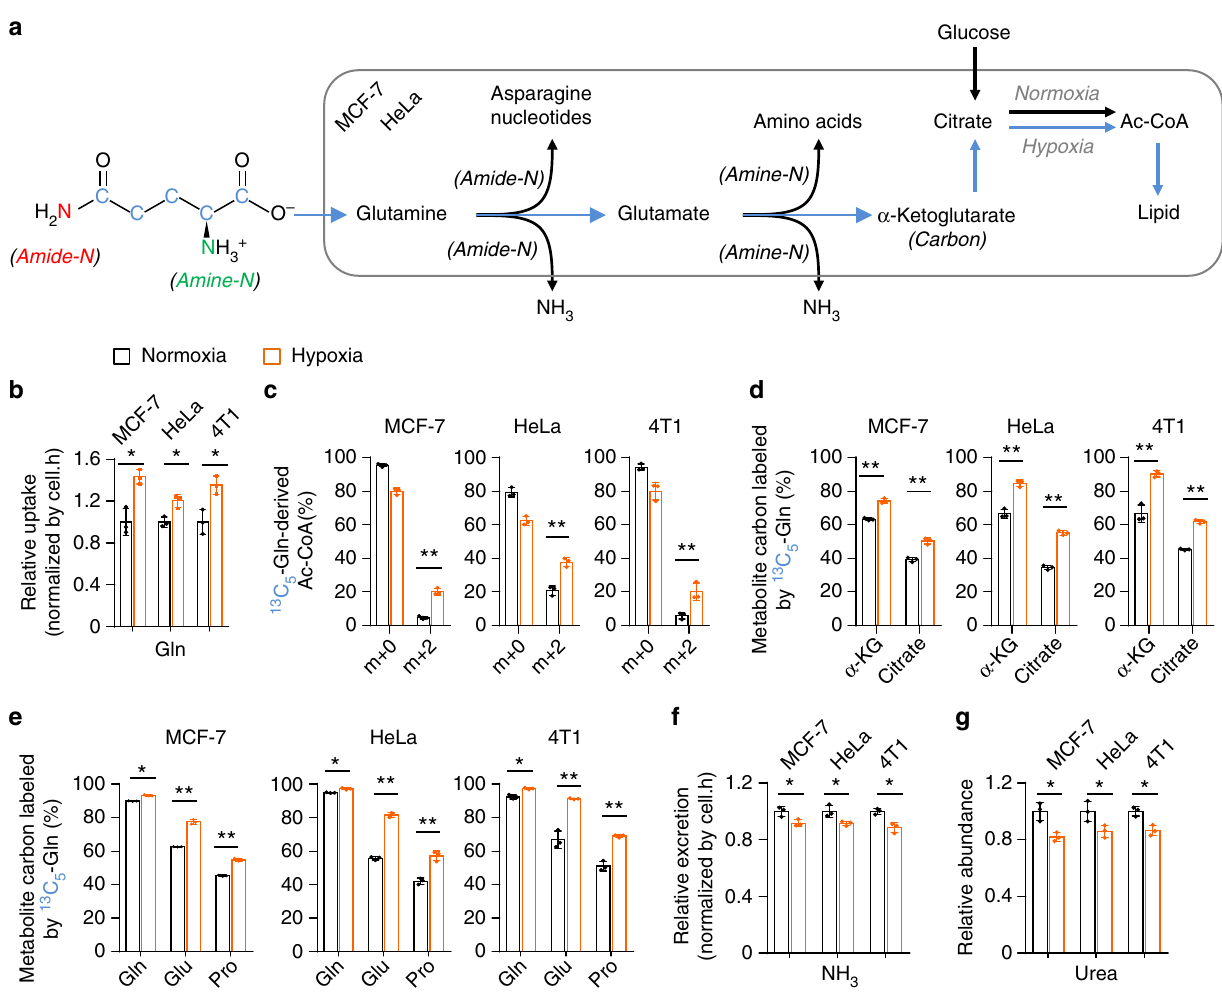
Fig. 1 Increased glutamine as the carbon source under hypoxia. a A schematic to show the metabolism of glutamine carbon and nitrogen. b Relative glutamine uptake in MCF-7, HeLa, and 4T1 cells cultured under hypoxia and normoxia for 8 h. c Mass isotopomer analysis of acetyl-CoA in MCF-7, HeLa, and 4T1 cells cultured with the medium containing 1 mM of 13 C 5 -glutamine under hypoxia and normoxia for 8 h. d , e The 13 C 5 -labeled fraction of metabolites in MCF-7, HeLa, and 4T1 cells cultured with the medium containing 1 mM of 13 C 5 -glutamine for 8 h under hypoxia or normoxia. f Relative ammonia excretion from MCF-7, HeLa, and 4T1 cells cultured under hypoxia and normoxia for 8 h. g Relative cellular urea in MCF-7, HeLa, and 4T1 cells cultured under hypoxia and normoxia for 8 h. All cultures were supplied with 10% dialyzed serum. Values are the means± SEM of three independent experiments. * p < 0.05; ** p < 0.01 (Student ’ s t